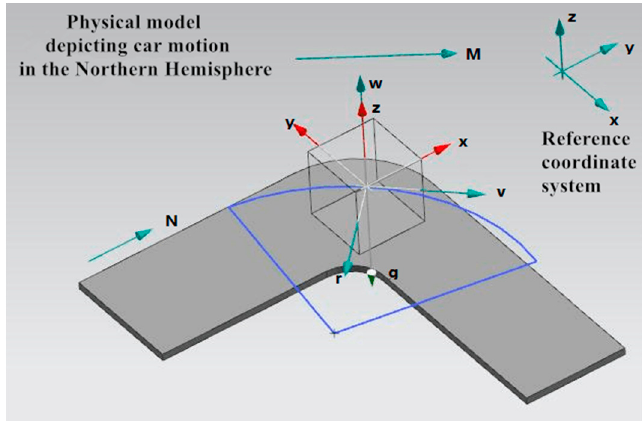
Figure 4. Physical model depicting car motion in the Northern Hemisphere.